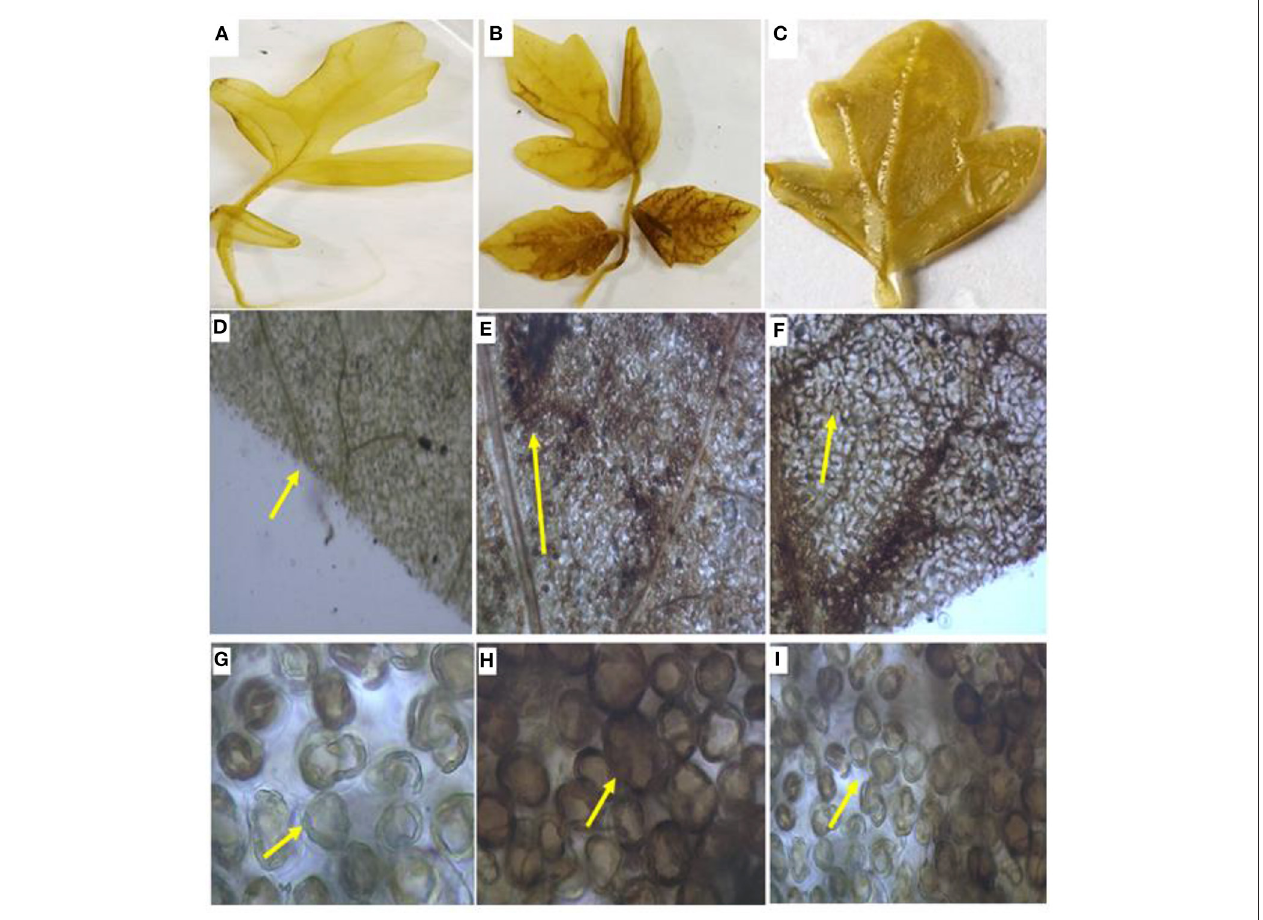
FIGURE 6 | The H 2 O 2 content in the tomato leaves. (A) Control leaf, (B) PC leaf ; (C) B1P1 leaf; (D) Control leaf under 10 times magnification, (E) PC leaf under 10 times magnification; (F) B1P1 leaf under 10 times magnification; (G) Control leaf under 40 times magnification, (H) PC leaf under 40 times magnification, (I) B1P1 leaf under 40 times magnification (yellow arrows indicate deposition of peroxide radicals in the leaf and around cells).